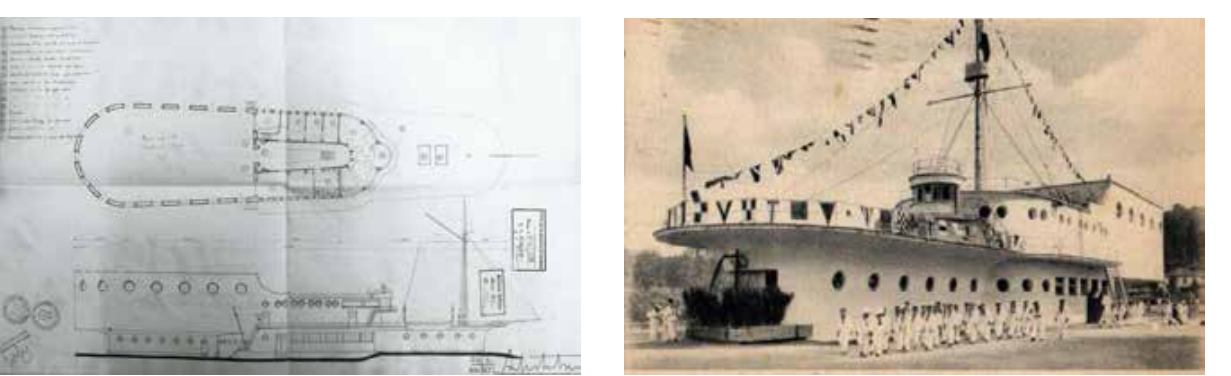
Figure 1. Archival drawing of the 'Casa del Marinaretto' by Costantino Costantini, 1936. Plan and elevation.